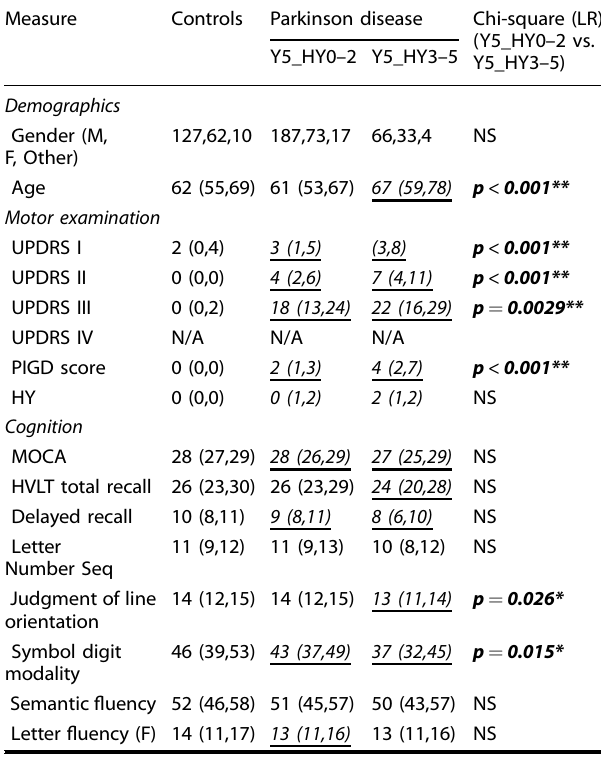
Table 1. Median and range of demographic, motor and cognitive measures including sex subgroups.